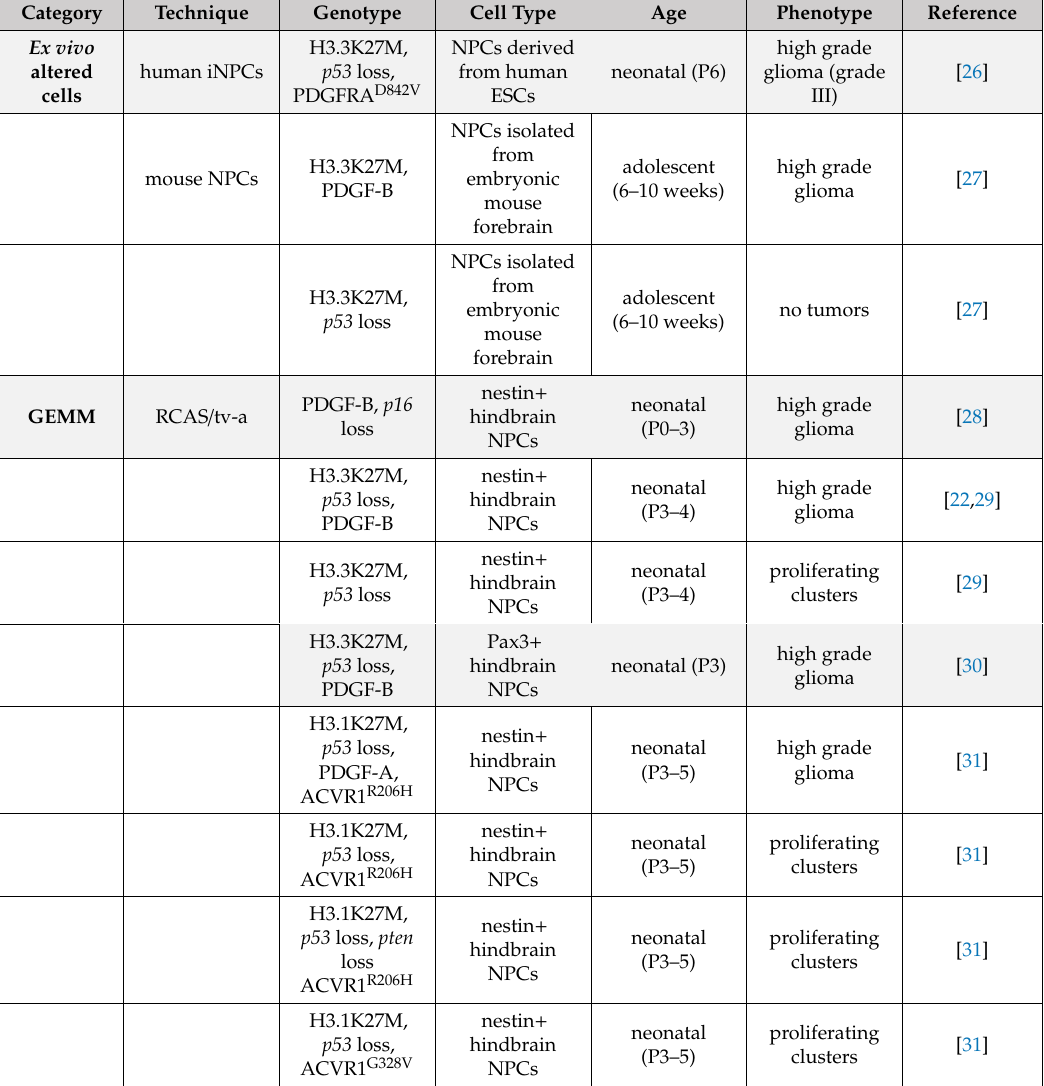
Table 1. Experimental models of histone-mutant pHGG. DNp53: dominant negative p53; ESC: embryonic stem cell; GFAP: glial fibrillary acidic protein; [i]NPC: [induced] neural progenitor cell; OPC: oligodendrocyte precursor cell; Pax3: paired box gene 3. See text for other abbreviations common to multiple tables and